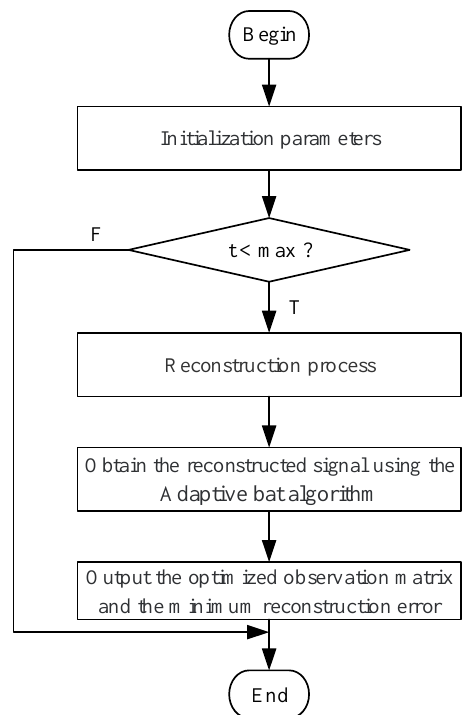
Figure 2. The flow chart of adaptive bat algorithm optimal observation matrix.